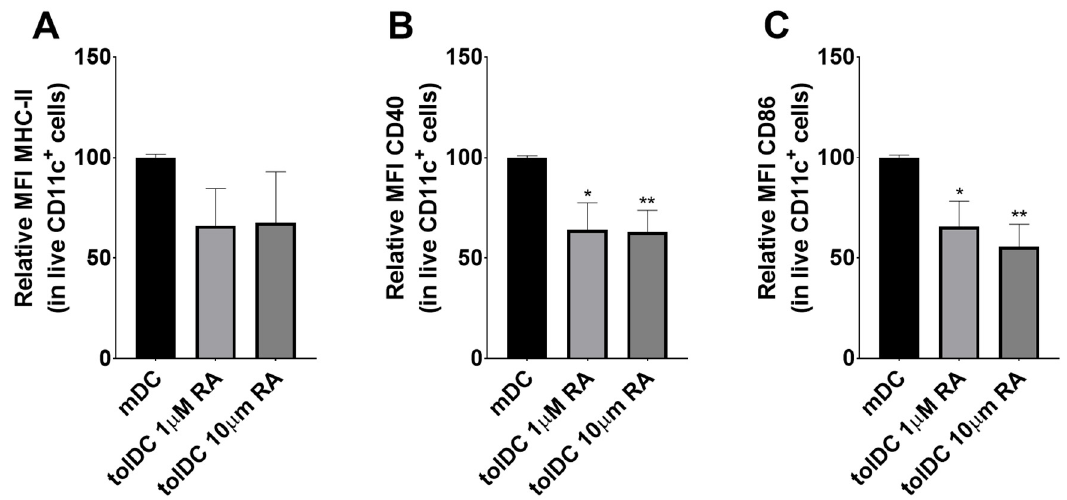
Figure 1. Addition of RA results in a tolDC phenotype in vitro. BMDCs were cultured from the bone marrow of Balb/c mice. BMDCs were stimulated with LPS (mDC) or LPS and different concentrations of RA (tolDC; 1 or 10 uM RA). The concentration of LPS was constant for all groups. After 24 h of incubation, cells were washed thoroughly to remove stimuli and analyzed via flow cytometry. Relative MFI normalized to mDC of ( A ) MHCII expression ( B ) CD40 expression, and ( C ) CD86 expression on live CD11c + BMDCs. Combined data of three independent experiments. n = 3. Means + SD, * p < 0.05, ** p < 0.01 compared to mDC, as determined by one-way ANOVA and Tukey’s multiple comparisons test.